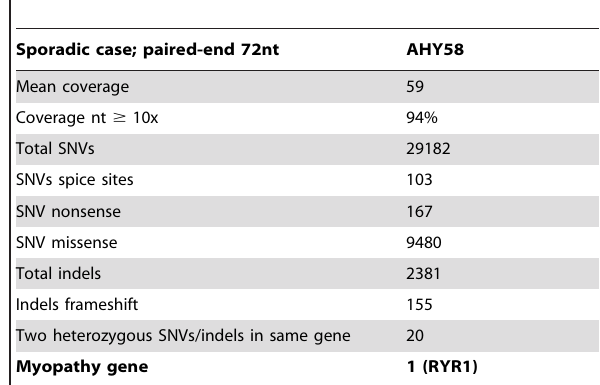
Table 2. Statistical overview of the exome sequencing results: sporadic cases (trio sequencing) ARX 30 and ARX33.